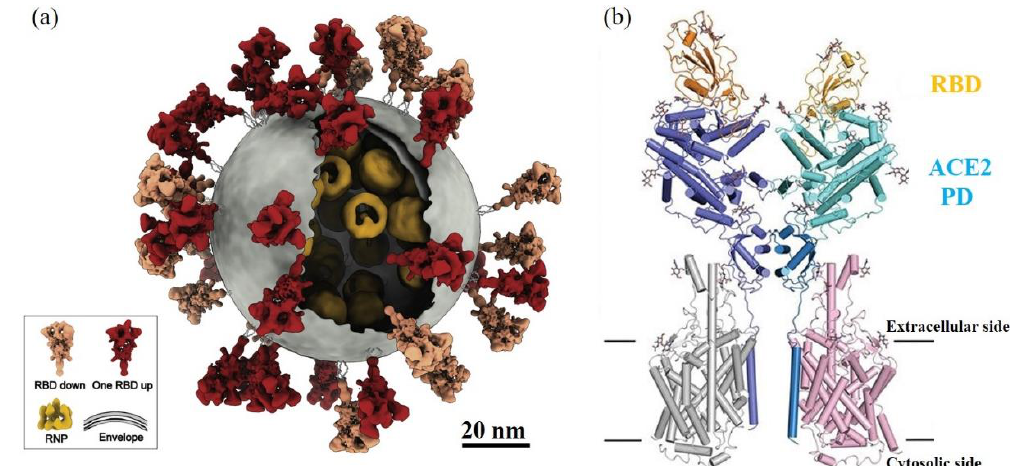
Figure 9. SARS-CoV-2 structure. ( a ) Molecular architecture of SARS-CoV-2 virus obtained by cryoelectron tomography and subtomogram averaging. The S protein in “RBD down” conformation, “one RBD up” conformation, lipid envelope, and ribonucleoproteins (RNPs) are shown in salmon, red, gray, and yellow, respectively [160]. ( b ) The cryoelectron microscopy structure of RBD-ACE2 complex